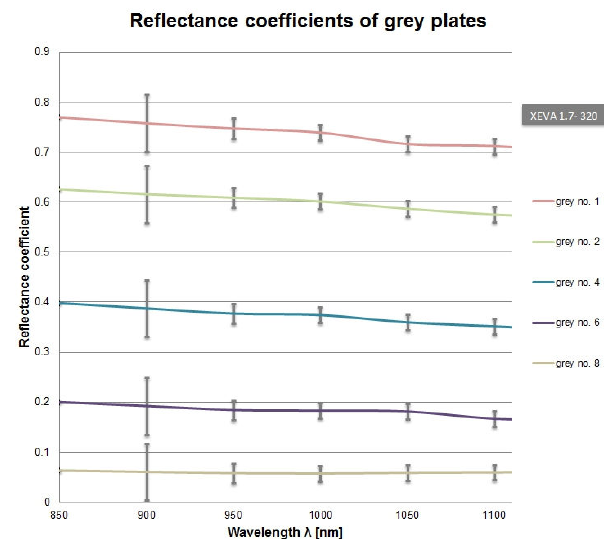
Figure 3. Reflectance coefficients of chosen grey plates with measurement errors (XEVA 1.7- 320 video camera)